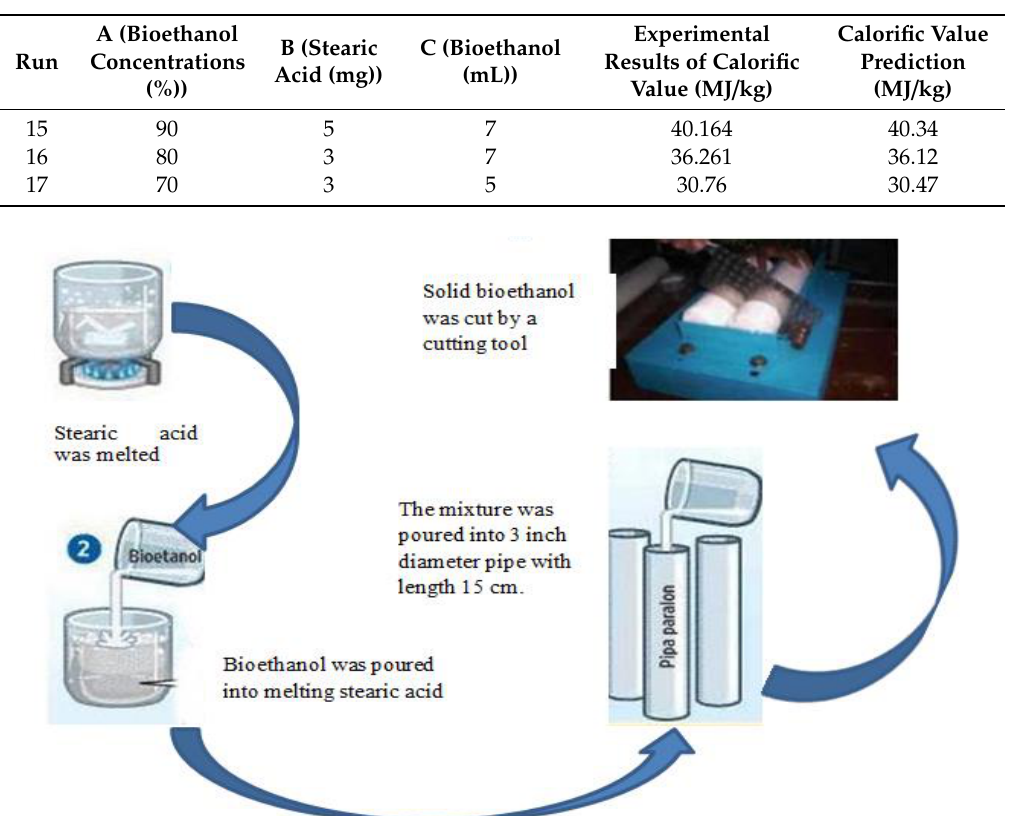
Figure 1. Solid bioethanol production by mixing bioethanol and stearic acid.